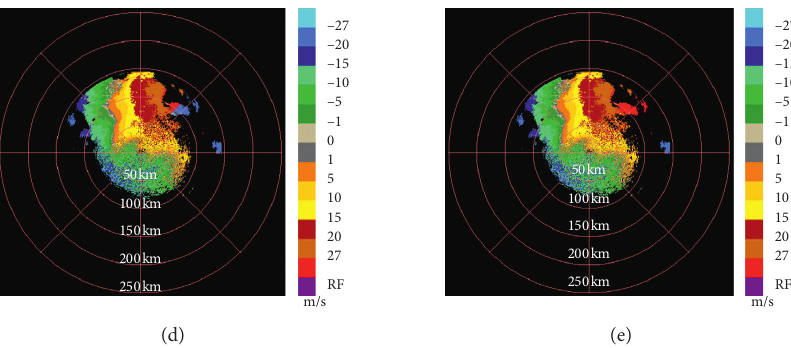
Figure 8: (a) The vector wind fields from the ERA-Interim at 500hPa at 18:00 UTC on May 13, 2016. The radial velocity field observed by Binzhou radar at 2.4 ° elevation angle at 18:13 UTC on May 13, 2016: (b) raw velocity field, (c) manually dealiased velocity field, (d) dealiased velocity field by the CIDA algorithm, and (e) dealiased velocity field by the MVDR algorithm. The manually dealiased results are marked by white ellipses in